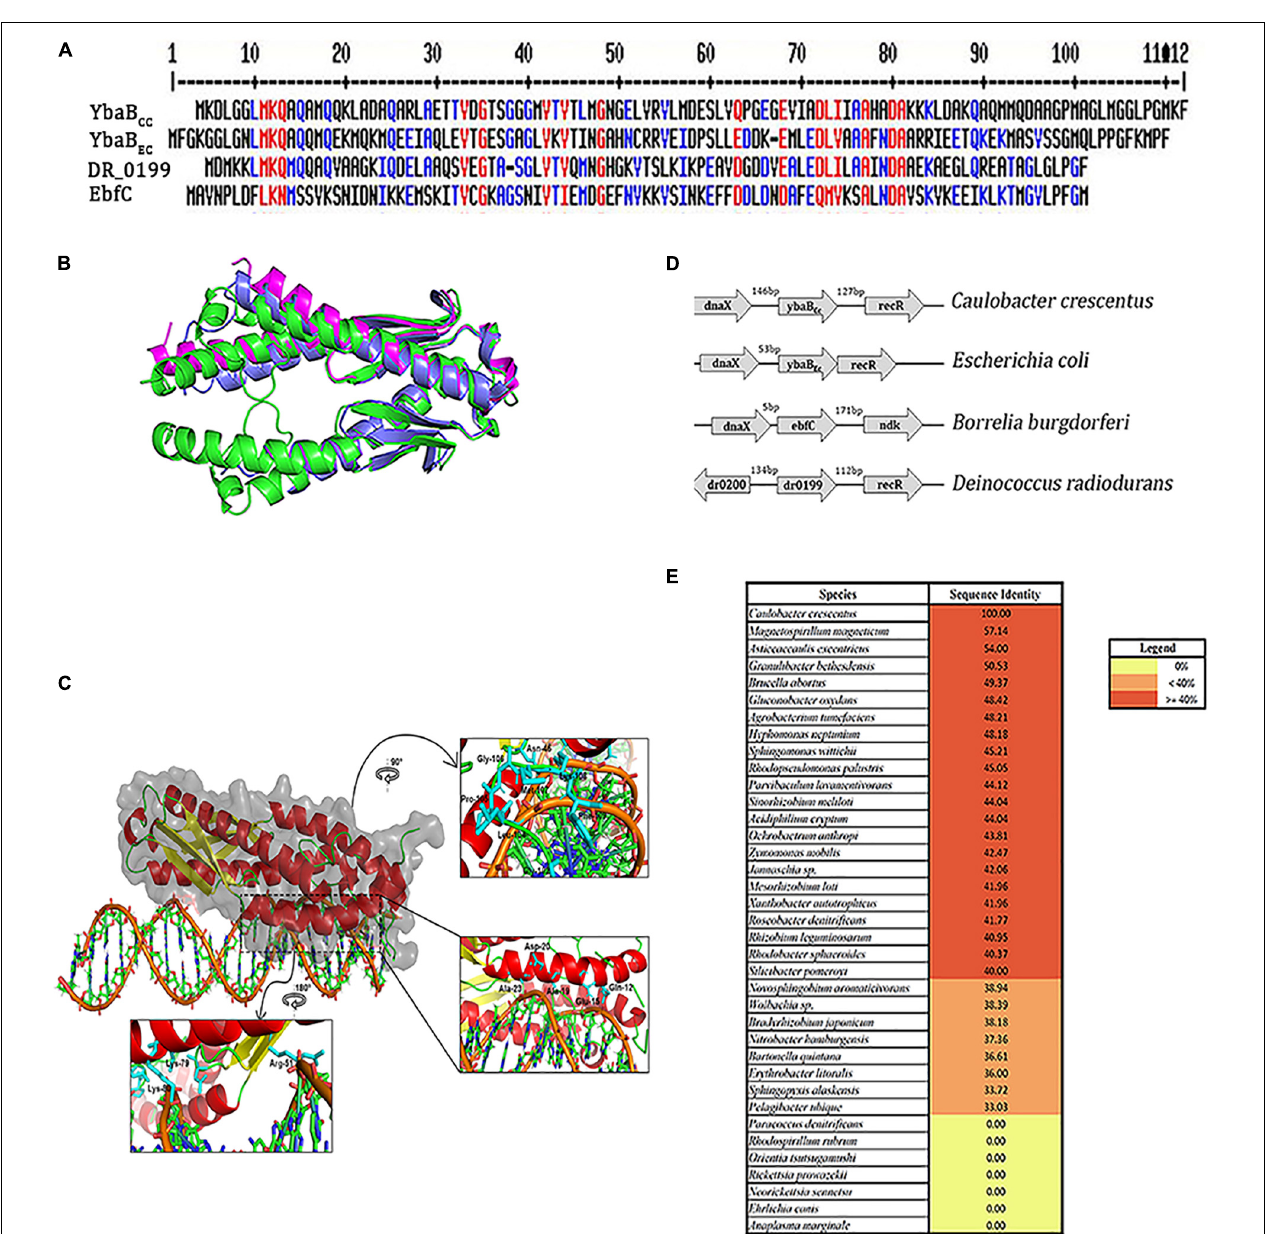
FIGURE 2 | YbaB cc is conserved across multiple bacterial species. (A) Multiple sequence alignment of YbaB/EbfC proteins from different bacterial species using MultAlin software (red—high consensus residues, blue—low consensus residues, at the given position). (B) Structural superposition of the modeled YbaB Cc protein with structural homologs. The modeled protein (colored green and shown in cartoon representation) is a homodimer, as seen in the structural homologs from E. coli (PDB id: 1PUG) colored light blue. Another structural homolog from Haemophilus influenza (PDB id:1J8B) colored magenta is in monomeric form. Image made using PyMOL. (C) Protein-DNA docking model of YbaB Cc (shown in cartoon and surface representation colored in secondary structure) is observed to bind to the DNA motif (5 (cid:48) -ATGTAACAGCTGAATGTAACAA-3 (cid:48) ) as obtained from HADDOCK web server. The insets show the orientation of side chains of the interacting residues in stick representation (colored cyan). (D) Schematic representation of the ybaB / ebfC gene locus with adjacent genes in various bacteria. This arrangement of genes appears to be conserved in most bacteria that harbor YbaB/EbfC proteins. (E) YbaB homologs in alpha proteobacteria. Genomes displaying YbaB homologs with more than 40% sequence identity are labeled in red and proteins having identity below 40% are labeled in orange. Bacterial genomes with no YbaB homologs are labeled in